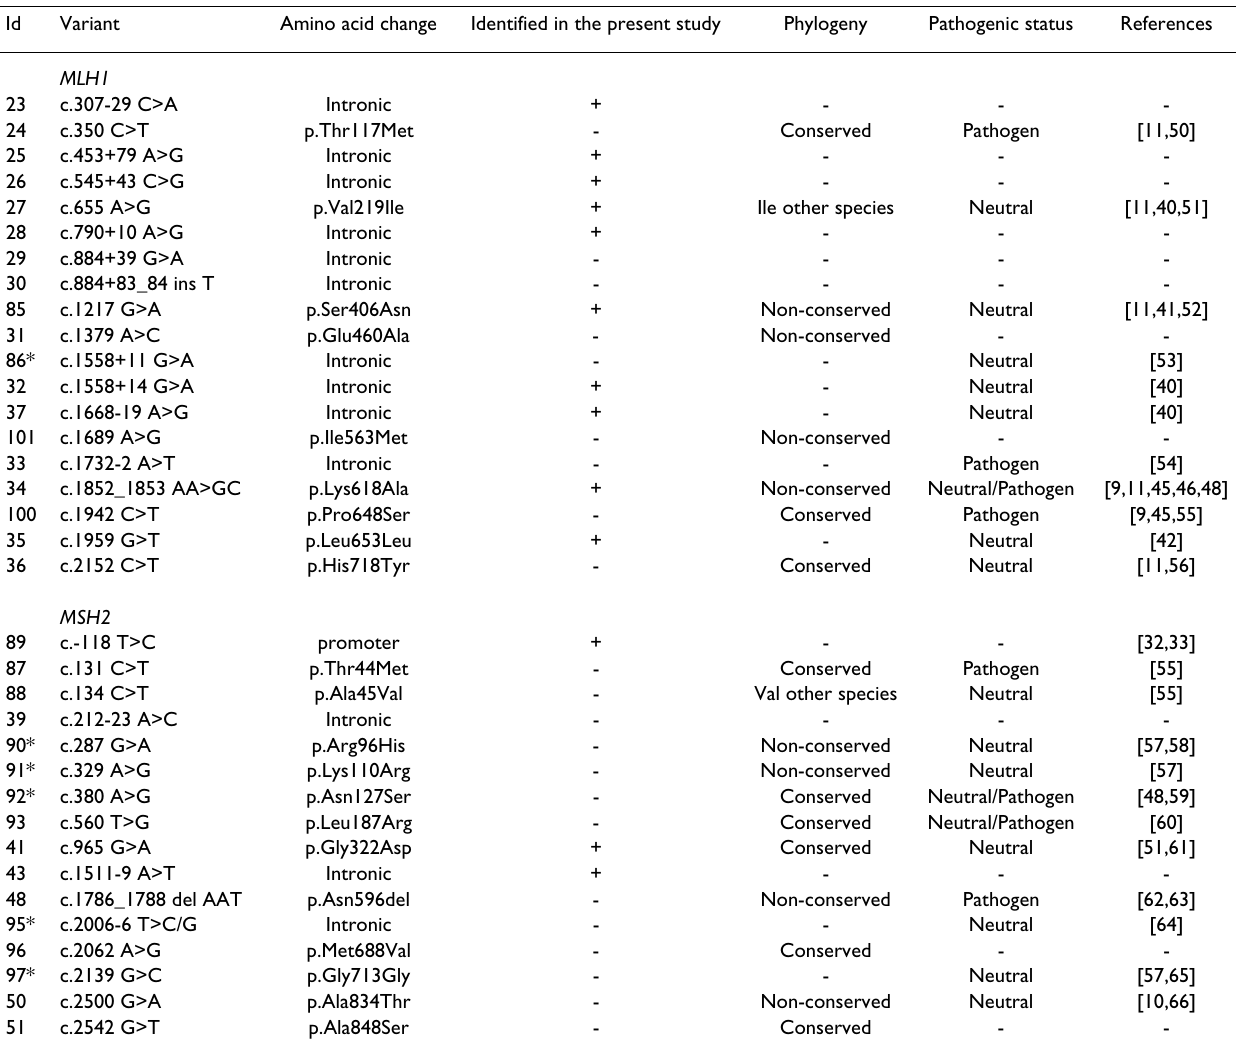
Table 2: MLH1 and MSH2